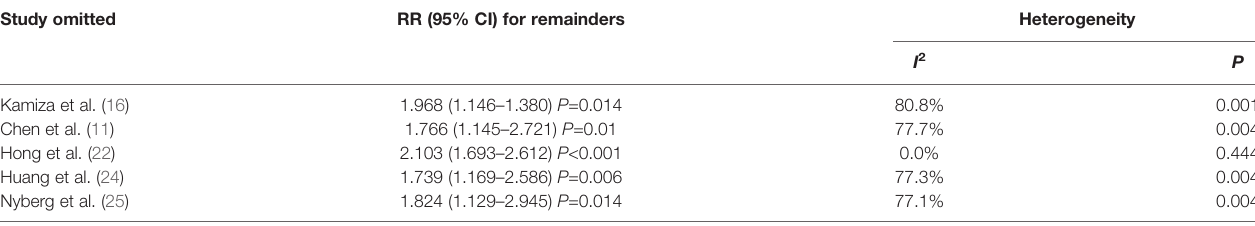
TABLE 3 | Sensitivity analysis after each study was excluded by turns in those studies reporting HCV and risk of gastric cancer. Study